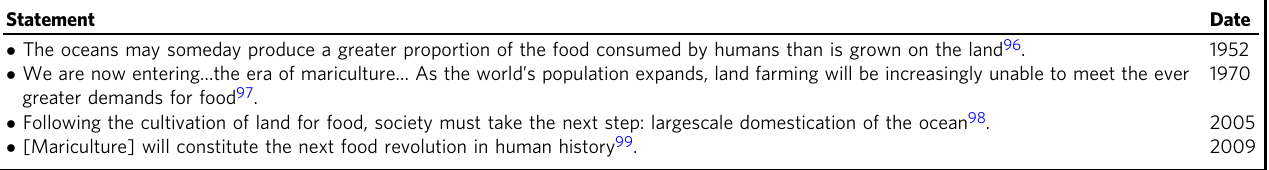
Table 1 Historical claims about the future of food